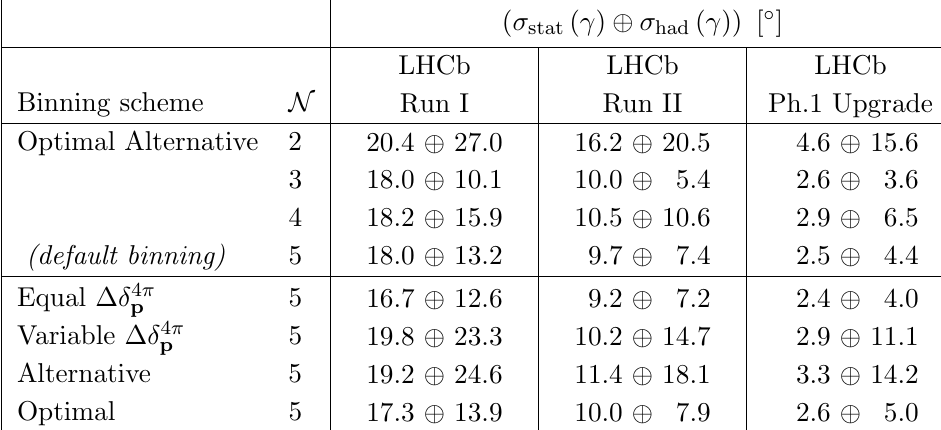
Table 8 . Expected (cid:13) sensitivity determined from simulated samples of B (cid:6) ! DK (cid:6) ; D ! 4 (cid:25) (cid:6) decays for a variety of D ! 4 (cid:25) (cid:6) binning schemes. Details of the simulation and (cid:12)tting procedure can be found in the text. The uncertainties are given for three di(cid:11)erent data taking periods of the LHCb experiment, where the number of signal decays in each case it taken/extrapolated from existing measurements. The uncertainty on (cid:13) comes from two sources: the uncertainty due to limited B (cid:6) ! DK (cid:6) ; D ! 4 (cid:25) (cid:6) statistics, (cid:27) stat ( (cid:13) ); and the uncertainty due to limited knowledge of the 4 (cid:25) (cid:6) hadronic parameters that are measured in this paper, (cid:27) had ( (cid:13) ). Both uncertainties are shown in the table, and are given in the format ( (cid:27) stat ( (cid:13) ) (cid:8) (cid:27) had ( (cid:13) )). All expected uncertainties are the median uncertainty from 100 simulated